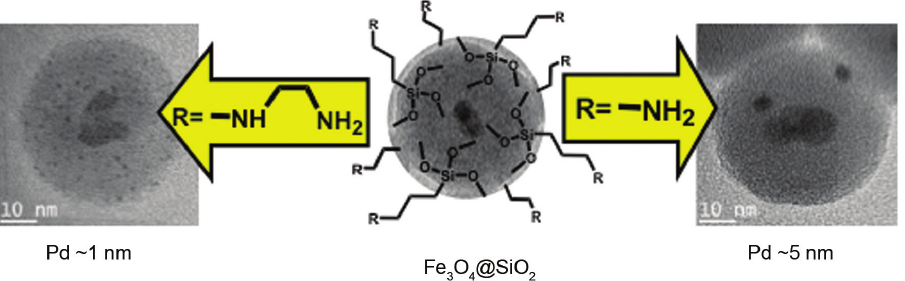
Figure 4 Core-shell silica-coated magnetite functionalized with amine and ethylenediamine groups as support for palladium NPs. Reprinted with permission from Ref. [26]. © 2009 American Chemical